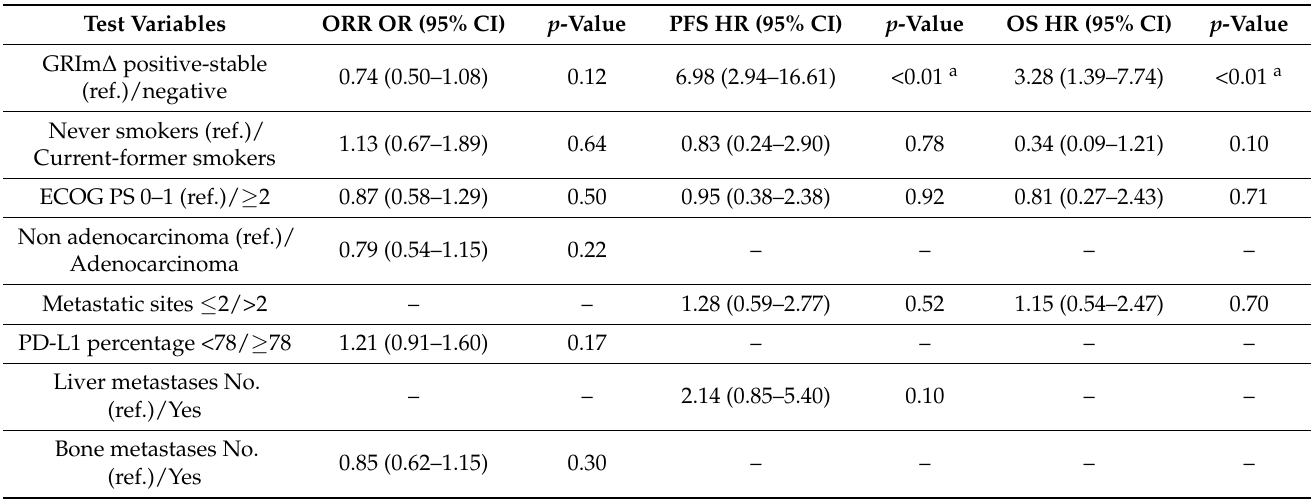
Table 3. Multivariable analyses for ORR, PFS and OS in pembrolizumab cohort considering GRIm ∆ as independent